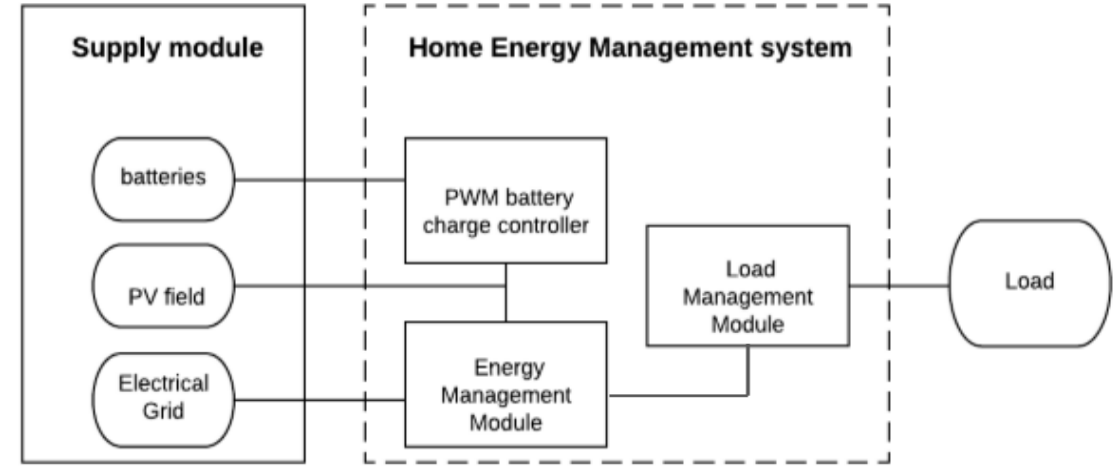
Figure 1. Interaction links between power supply and load via the HEM System.